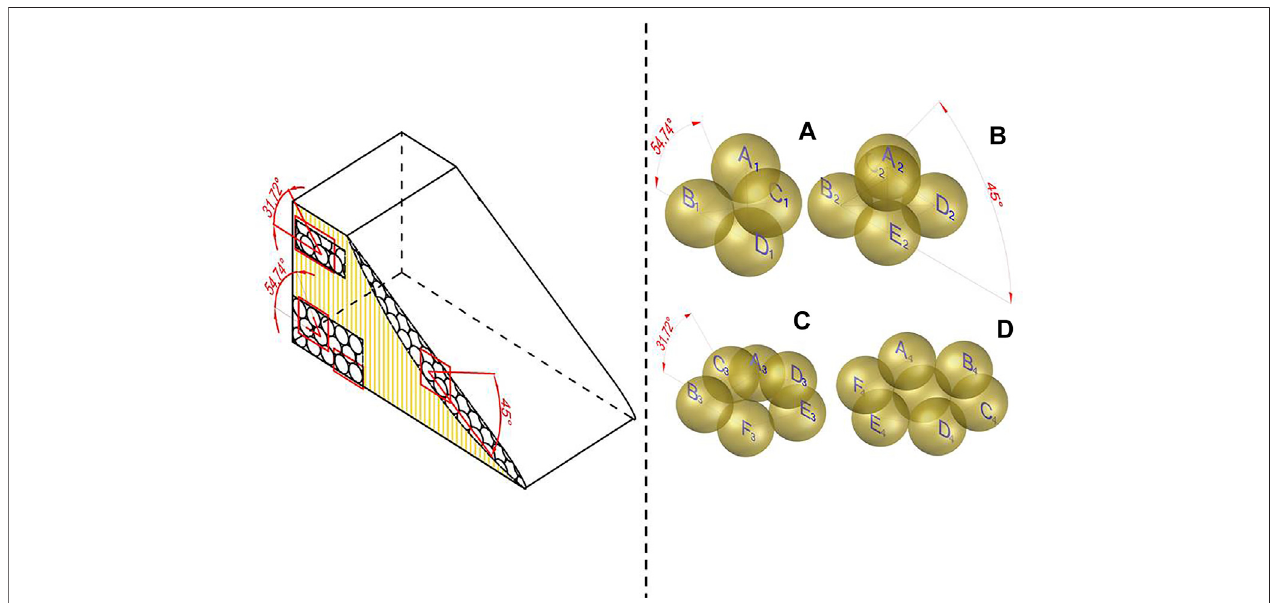
FIGURE 3 | Four different contact models. (A) Triangular pyramid contact structure; (B) rectangular pyramid contact structure; (C) pentagonal pyramid contact structure; (D) hexagon contact structure.